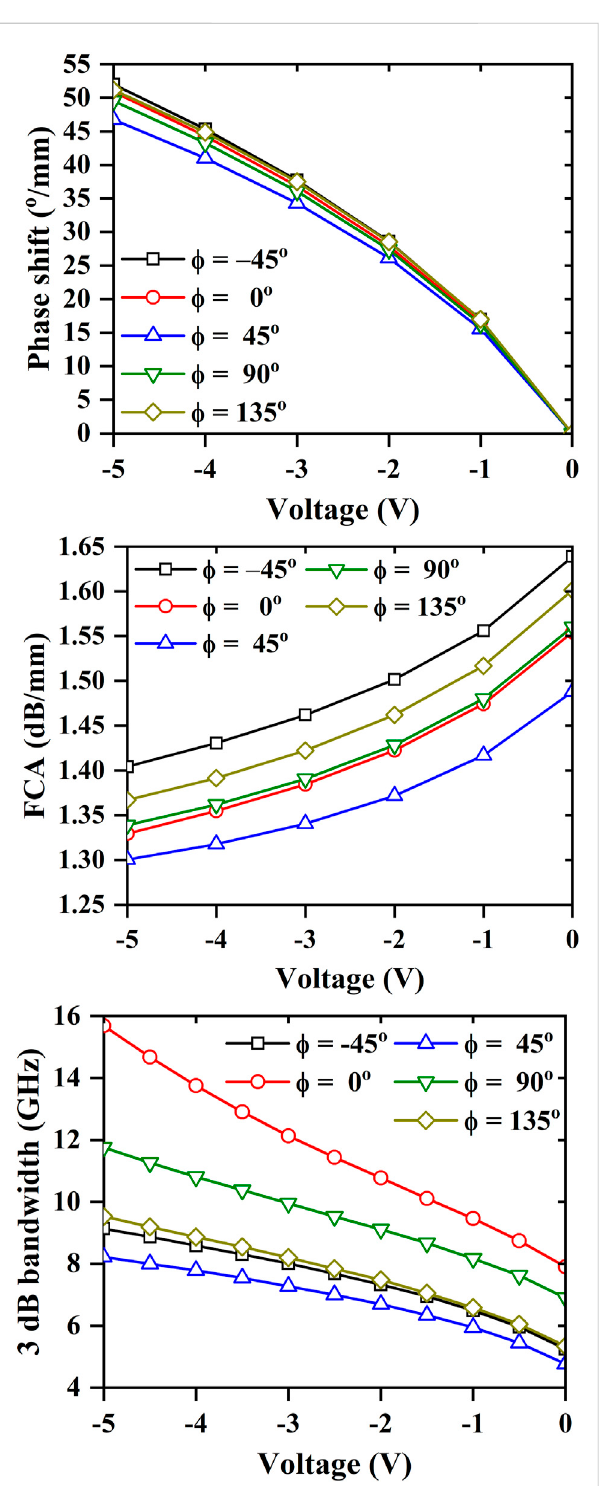
FIGURE 8 (A) Phase shift per unit length, (B) free-carrier absorption per unit length, and (C) 3-dB bandwidth for different wafer rotations at 7 ° tilt. evaluated: 800 ° C for 180 s, 900 ° C for 90 s, 1,000 ° C for 30 s, and 1,100 ° C for 10 s (reference). The phase shift and FCA per unit length curve for the different annealing conditions are shown in Figures 5A,